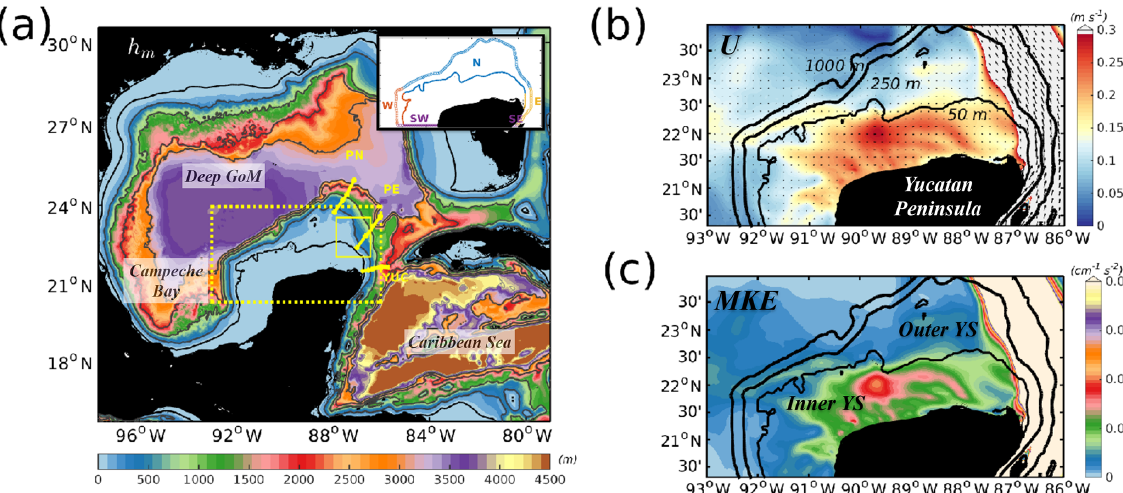
Figure 1. Bathymetry ( h m , m) of the whole model domain. Isobaths: 50, 250, 1000, 2000, 3000, and 4000m are also shown in grey contours. The small box at the upper right corner of (a) shows the north, east, south, and west boundaries used to compute the inner- and outer-shelf TN cross-shelf fluxes. The yellow dashed box delimits the study area of the Yucatán shelf, where (b) is the surface temporally averaged velocity field ( U , ms − 1 ) with magnitude in colour and vectors representing the direction, and (c) is the surface mean kinetic energy (MKE, cm 2 s − 2 ) computed for the year 2010. The smallest yellow box in (a) shows the “notch” area (see text) and the three yellow lines are the mooring locations for transects YUC, PN, and PE. Labels help identify the Deep Gulf of Mexico, Campeche Bay, and Caribbean Sea regions in (a) . The inner and outer Yucatán shelf are shown in (c) .